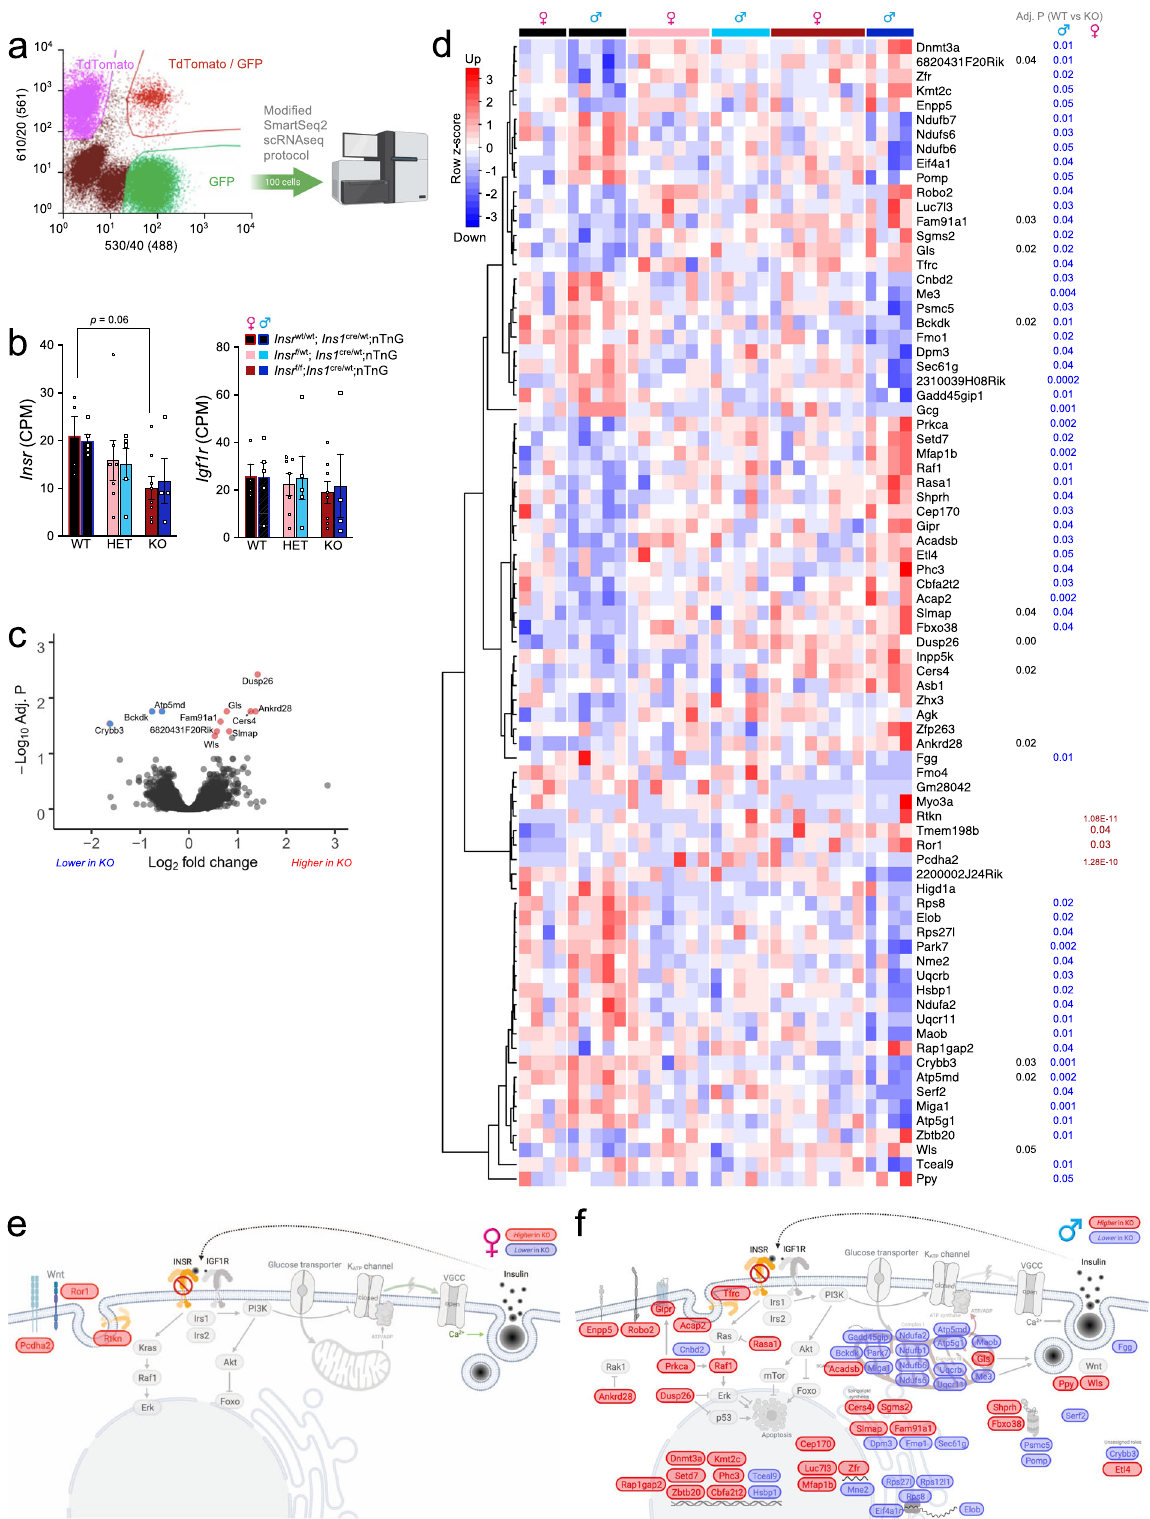
glucose-stimulated insulin secretion without much impact on basal insulin